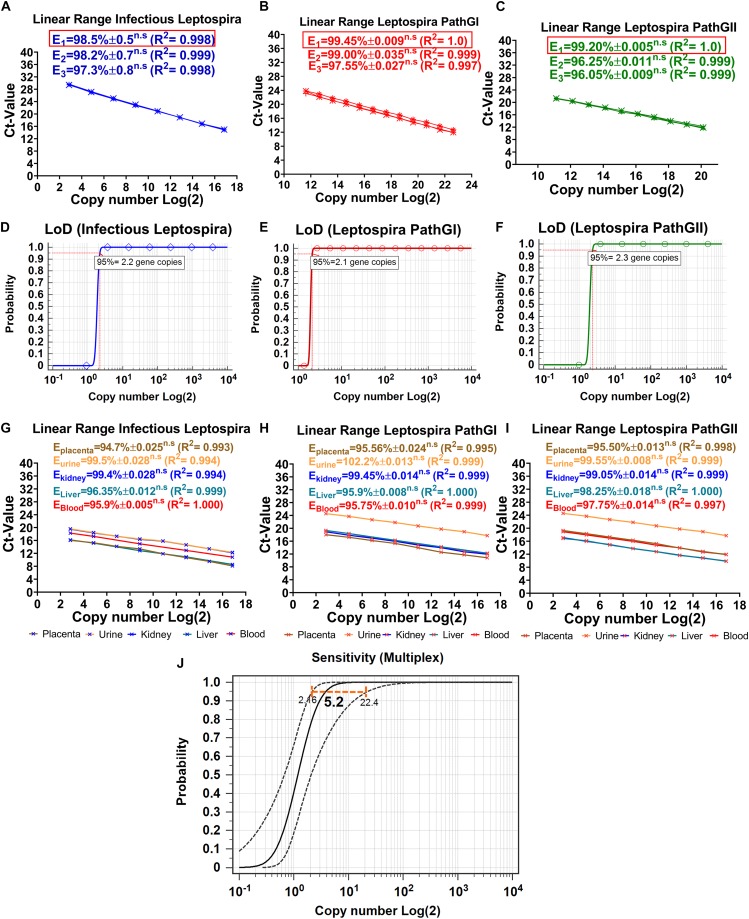
Dynamic range, limit of detection, matrix-effect, and analytical sensitivity of the novel multiplex qPCR assay. Evaluation of the different concentrations of primers and probes on efficiency and dynamic range of the reaction specific for the detection of (A) infectious Leptospira spp. group (also denoted in blue), (B) pathogenic group I (also denoted in red), and (C) pathogenic group II (also denoted in green). All the values of efficiency of the reaction are shown, the linearity of the reaction is also shown; in all cases, E1 was determined with 0.3 μM primers and 0.15 μM probe, E2 was determined with 0.4 μM primers and 0.2 μM probe, E3 was determined with 0.5 μM primers and 0.25 μM probe, n.s: no statistically significant differences. Evaluation of the LoD, probit function for each specific reaction is shown: (D) reaction targeting infectious Leptospira spp. group (also denoted in blue), (E) reaction targeting pathogenic group I (also denoted in red), and (F) reaction targeting pathogenic group II (also denoted in green); LoD value detected with 95% of confidence is shown. Evaluation of the matrix-effect on efficiency and the linearity of the reaction for each target region: (G) infectious Leptospira spp. group, (H) pathogenic group I, and (I) pathogenic group II. All the efficiency values for each matrix are shown, each matrix is denoted and highlighted (placenta: brown, urine: yellow, kidney: blue, liver: turquoise, blood: red). All the values of efficiency of the reaction are shown, the linearity of the reaction is also shown, n.s: no statistically significant differences. (J) Representative evaluation of analytical sensitivity (ASe) of the multiplex qPCR assay, 95% confidence interval estimated for kidney tissue homogenate matrix is shown (all the remaining matrices yielded same result), value of the ASe determined by probit function is highlighted in bold case.